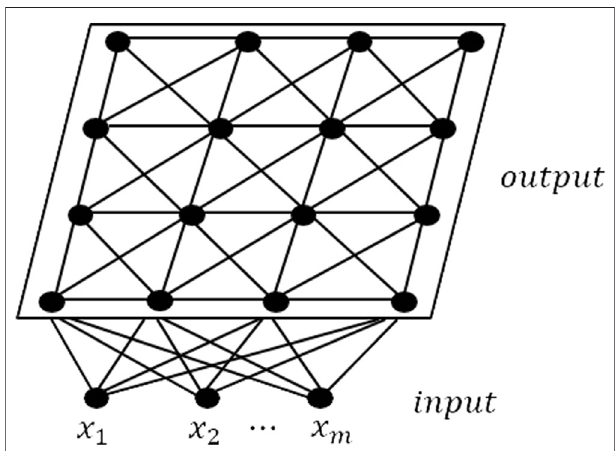
FIGURE 1 | The schematic plot of a self-organizing map (SOM) cluster analysis model with its input and output layers. The input layer is the normalized sea level pressure. Through the unsupervized learning algorithm, each neuron in the output layer is matched with the input sample. The fi nally winning neuron is the classi fi cation of sea level pressure, and the nodes in the output layer represent the types of circulation.